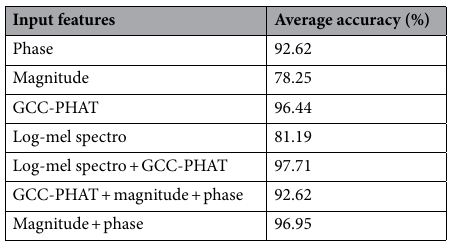
Table 3. Average accuracy of the model with different input